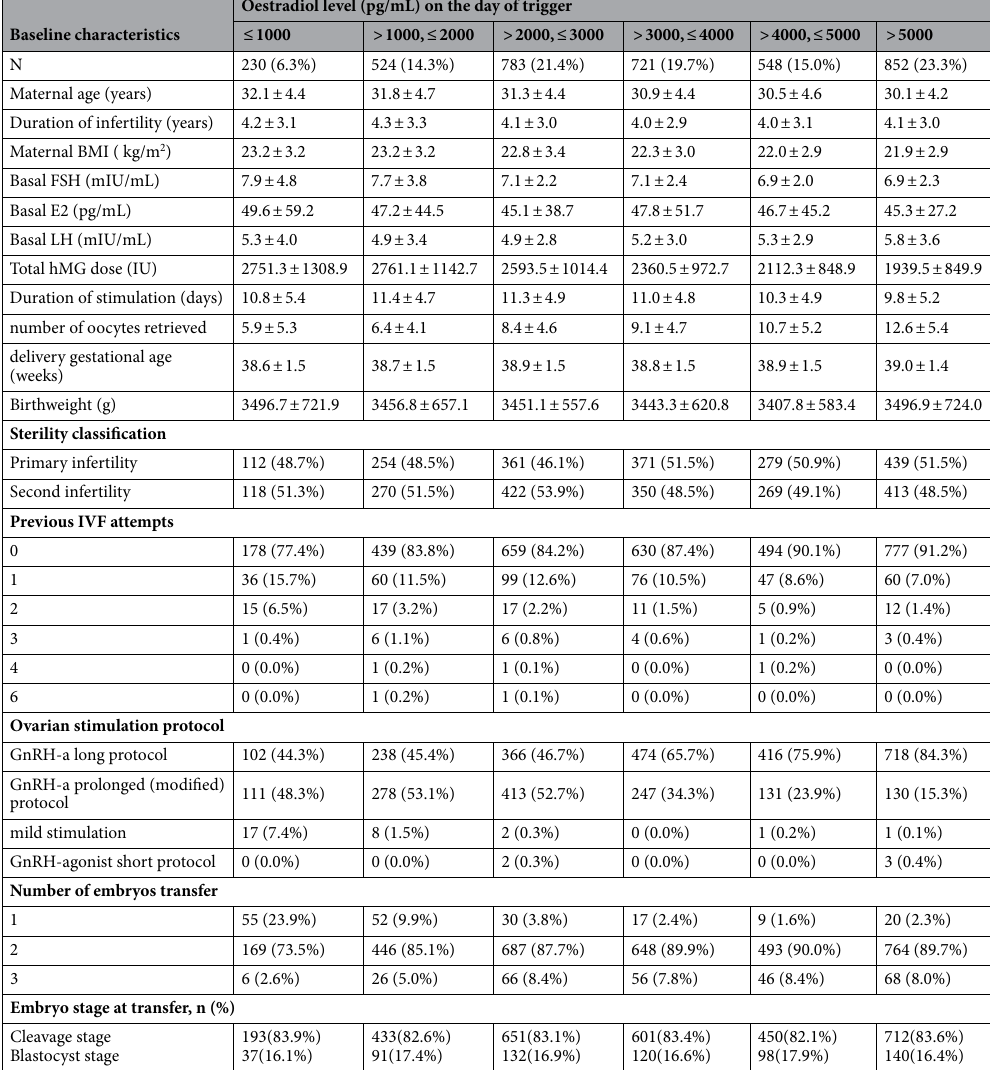
Table 1. Baseline characteristics of the study participants. Data are presented as the mean ± SD or number (percentage). BMI: Body mass index; FSH: Follicle-stimulating hormone; E2: Oestradiol; LH: Luteinizing hormone; IVF: In vitro